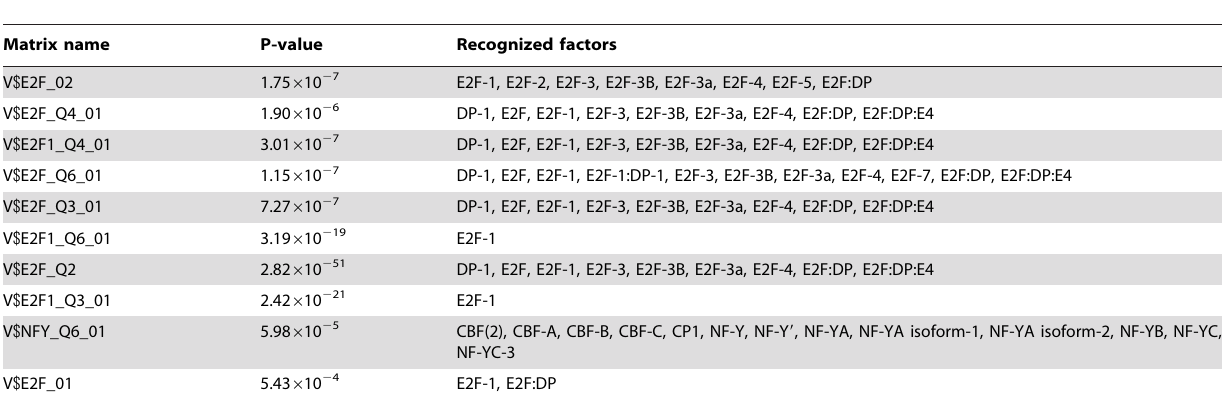
Table 2. Transcription factor binding site analysis for the 26 down regulated cell cycle genes.